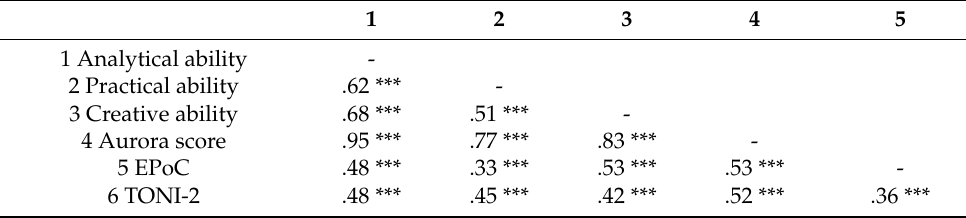
Table 7. Correlation matrix among Aurora, TONY-2 and EPoC (N =